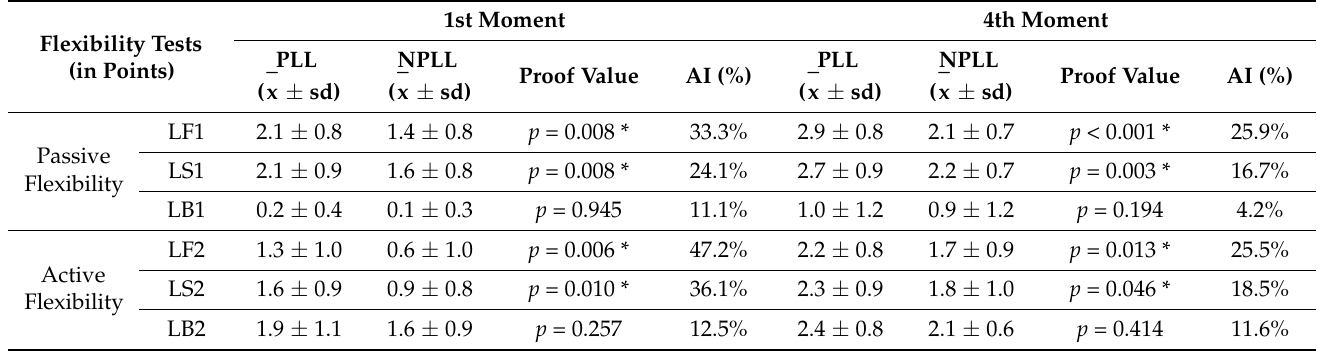
Table 2. Asymmetry levels in flexibility tests in first and fourth moments of